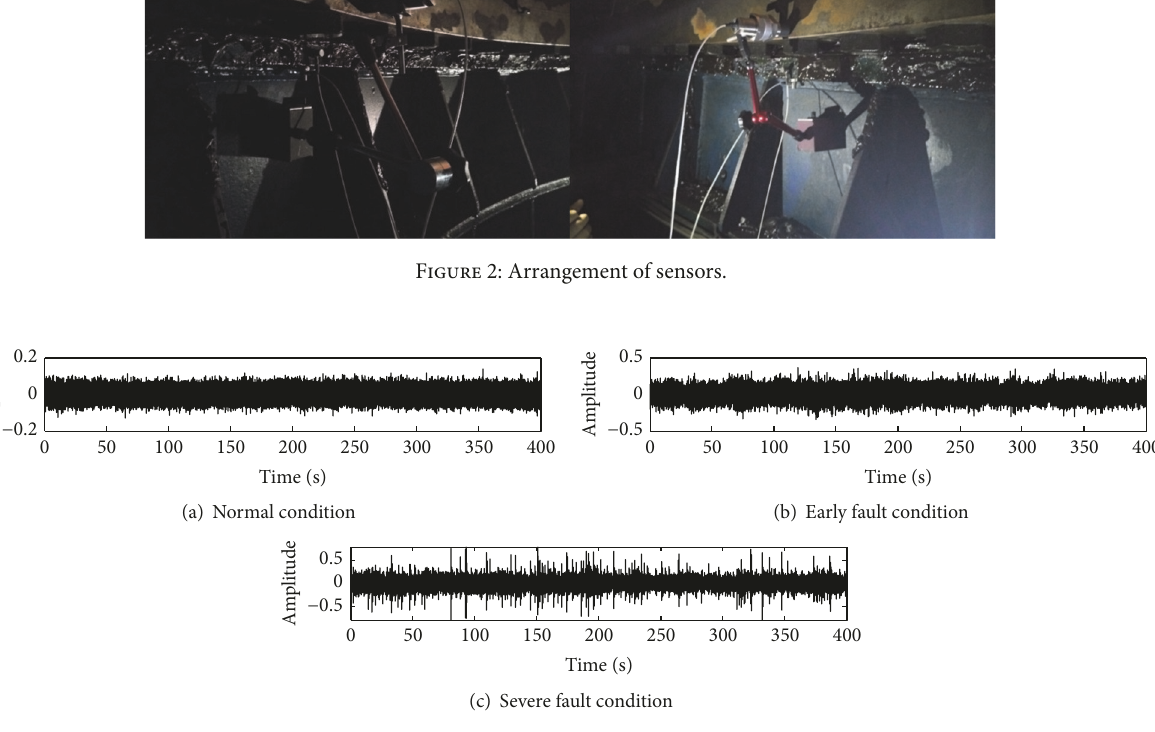
Figure 3: Time-domain signals of various conditions (the data were acquired on Oct. 15, 2015; Oct. 25, 2016; and Oct. 26, 2017,